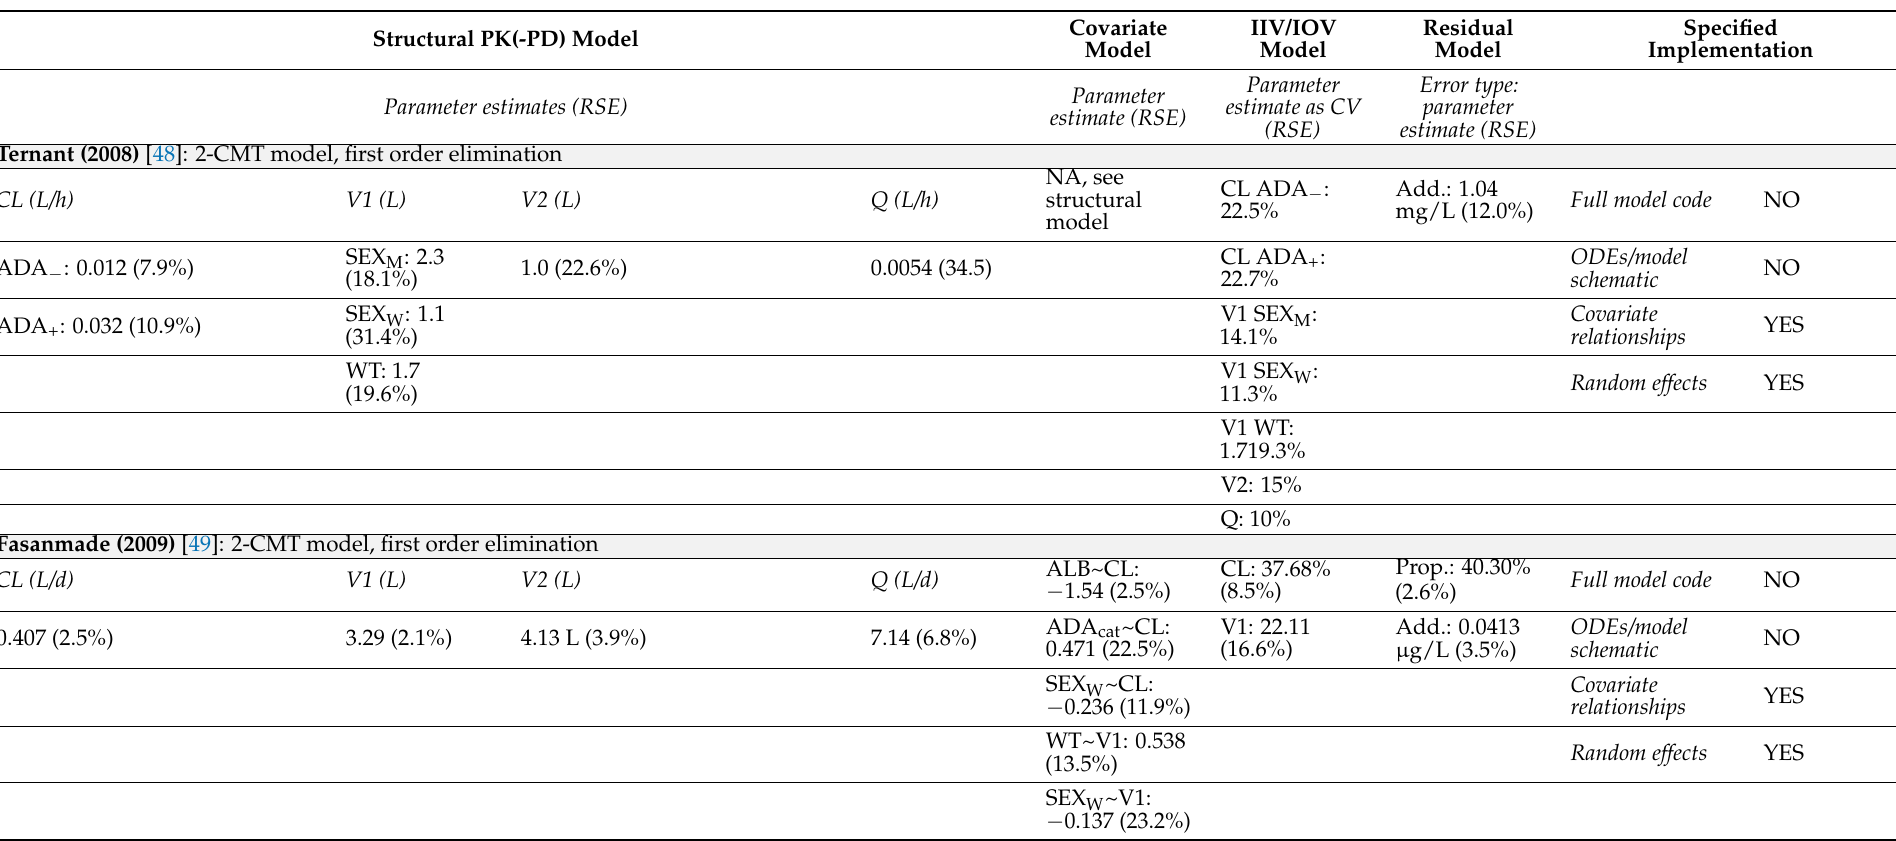
Table 2. Selected population pharmacokinetic models for infliximab in ulcerative colitis or inflammatory bowel diseases